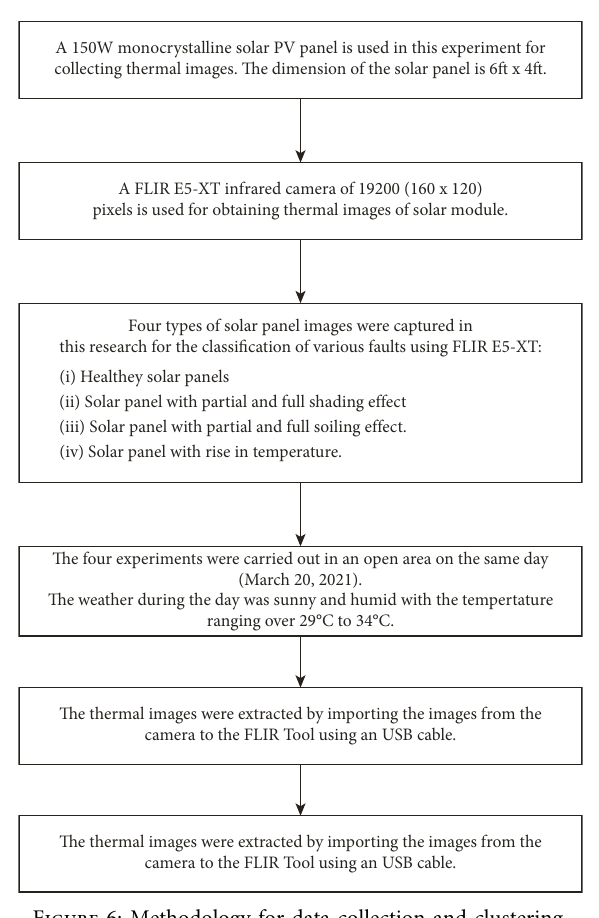
Table 2: Number of thermal images used in each training class. S.